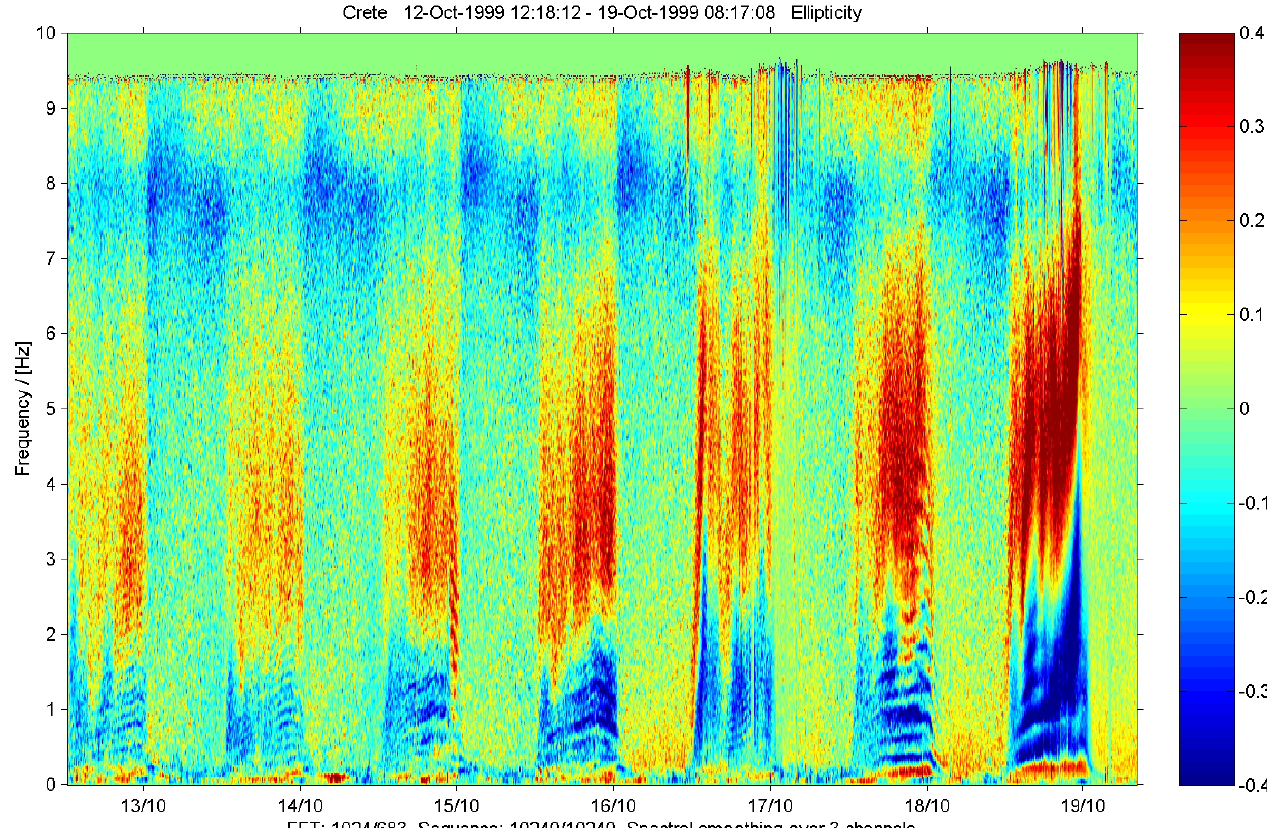
Fig. 1. Dynamic spectra of the ellipticity (cid:15) of magnetic background noise observed at Crete as a function of time and frequency for a week of data in October 1999. The figure shows the value of (cid:15) by means of a color code with positive values for right-hand and negative values for left-hand polarized waves. The (cid:15) parameter is defined between plus and minus unity. Local midnight is UT plus 1.5h. The tick on the abscissa is at 02:00 UT; the date is of the previous day. For more details see